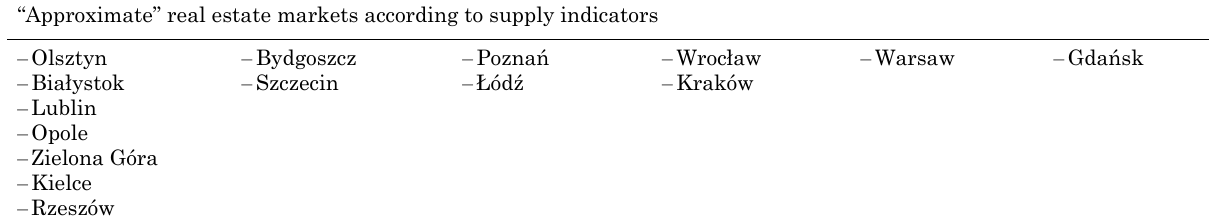
Table 3. Classification of real estate markets based on key quantitative similarities “Approximate” real estate markets according to supply